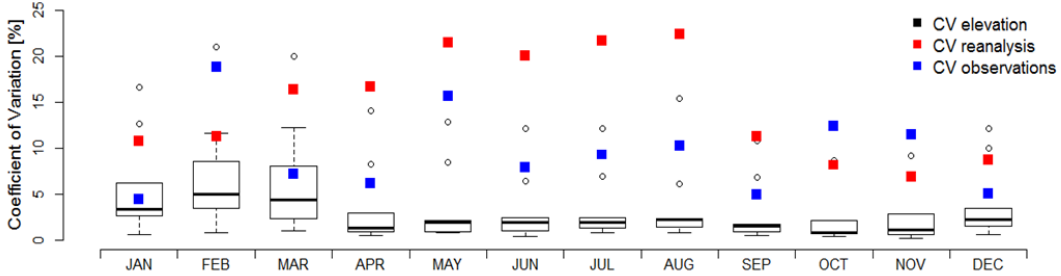
Figure 11. Coefficient of Variation (CV) with respect to the source of the data sets for observational grids (blue) and reanalysis data sets (red), compared to CV introduced only by elevation (boxplots, black).